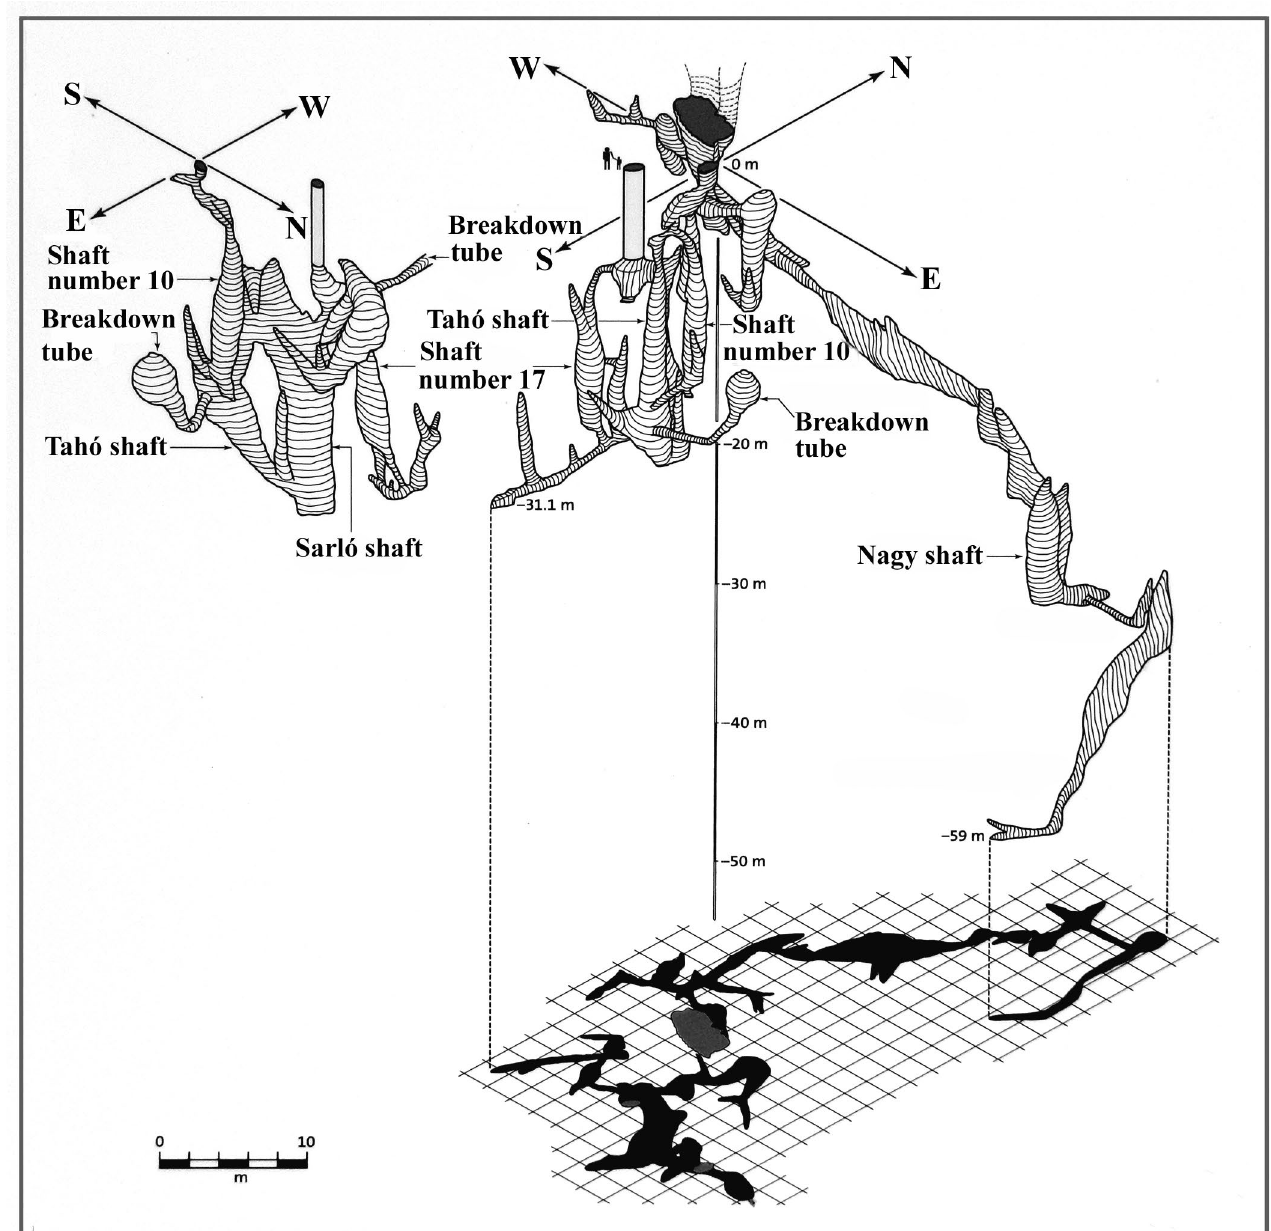
Figure 9. Öregköves ponor shaft cave [34].